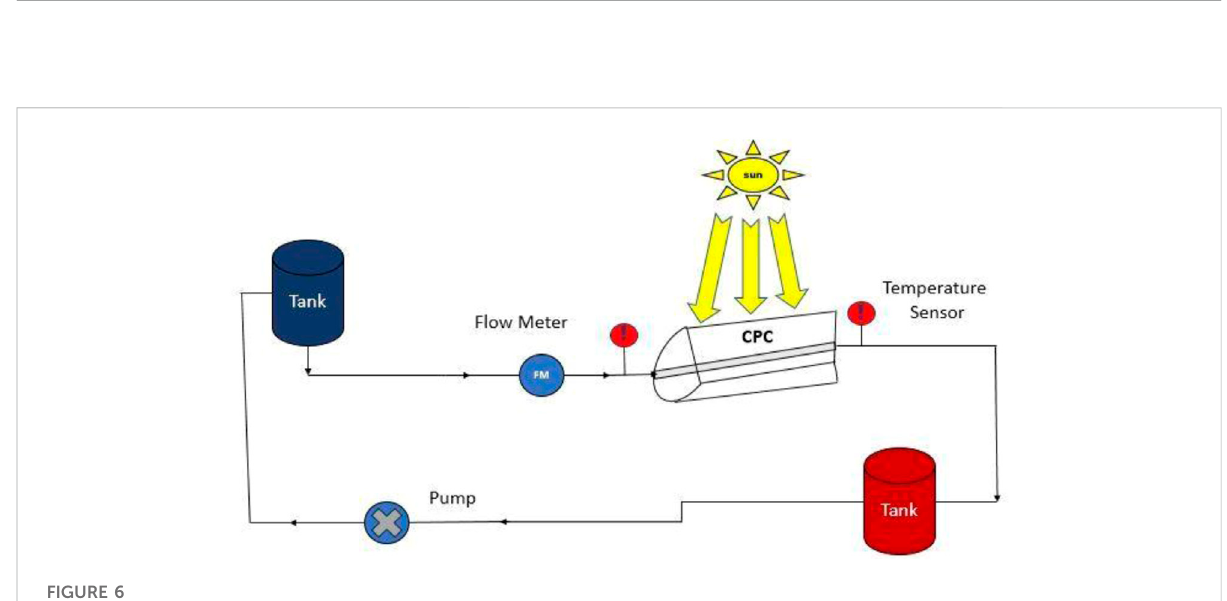
NFs/hybrid NFs. For steady output, high-temperature water